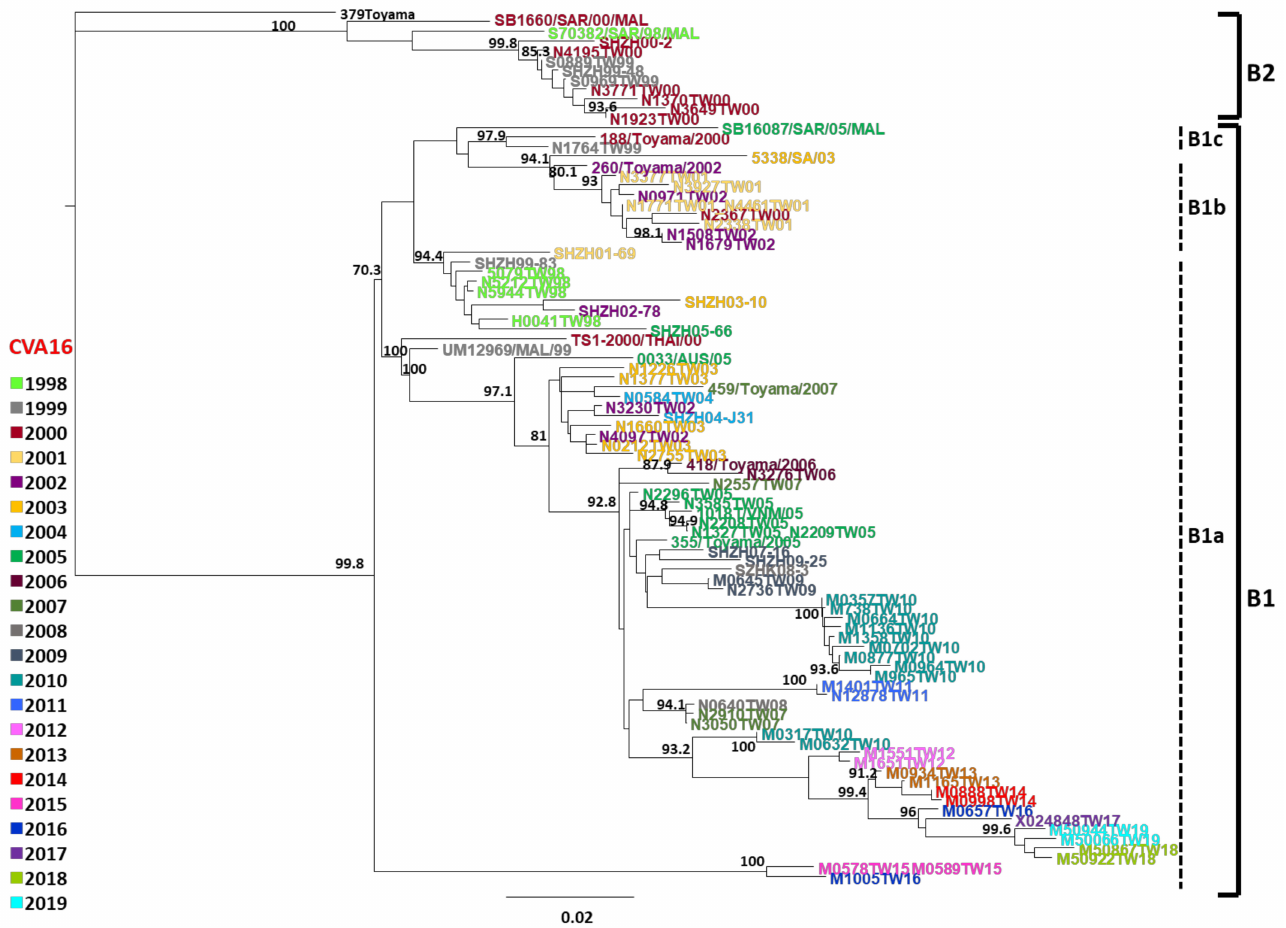
Figure 3. Phylogenetic analysis of CVA16 isolates from Taiwan and other countries based on the VP1 region (nt 2446-3325, 834 bp). A phylogenetic tree was estimated by the GTR model of the PAUP 4.0 program. Statistical robustness of 1,000 data sets were analyzed and statistical estimation of the significance of branch lengths was also determined by the maximum-likelihood method. Bootstrap values (percent of 1000 pseudoreplicate data sets) of over 75% supporting each cluster are shown at the nodes. CVA16 379/Toyama/1984 was included as an outgroup. Toyama: Japan; MAL: Malaysia; SZ and SHZH: Shenzhen, China; TW: Taiwan; SA: Saudi Arabia; AUS: Australia; THAI: Thailand; VNM: